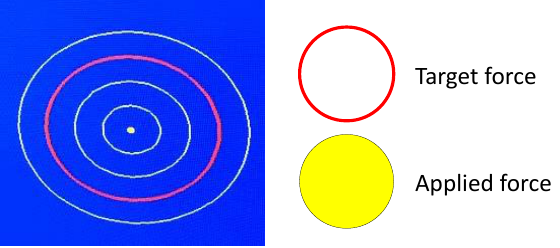
Figure 3. Visual feedback Figure 5. Visual